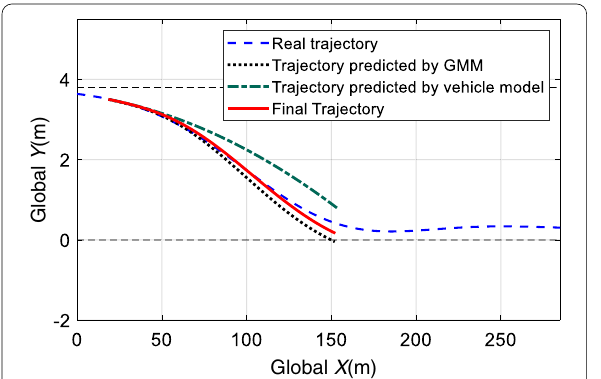
Figure 5 Trajectory prediction at 0.4 s after the start of lane change